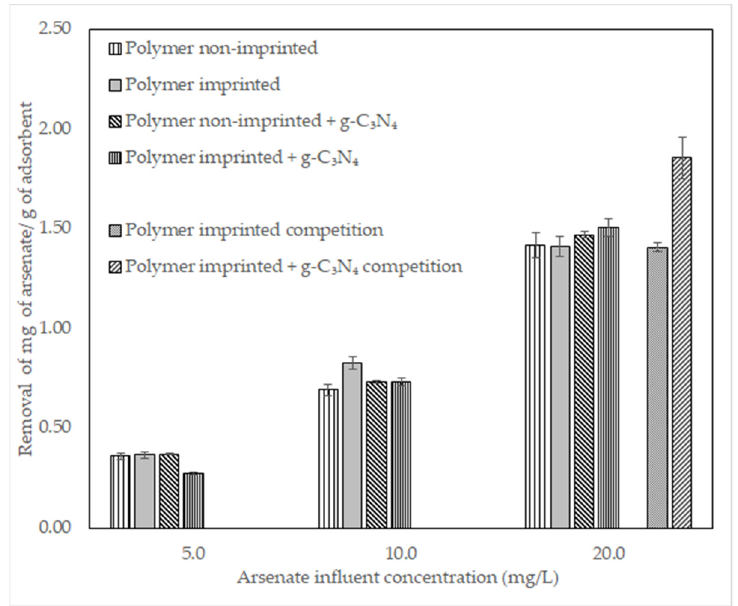
Figure 5. Removal of arsenate in columns by specified materials at different arsenate concentrations in the influent. Imprinted polymer with g-C 3 N 4 outperforms all materials in competition experiment at the highest concentration, showing the selectivity of the material.